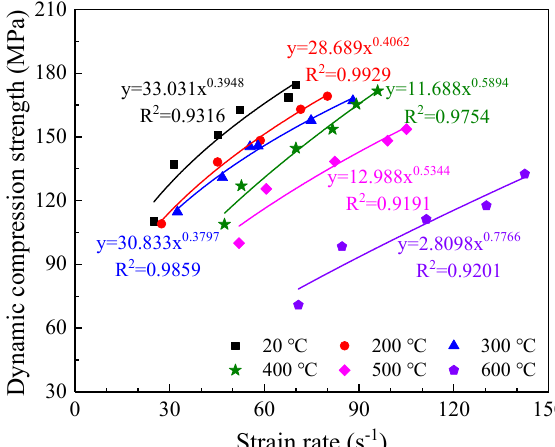
Figure 8. Relationship between strain rate and dynamic compressive strength of granite after thermal shocking.